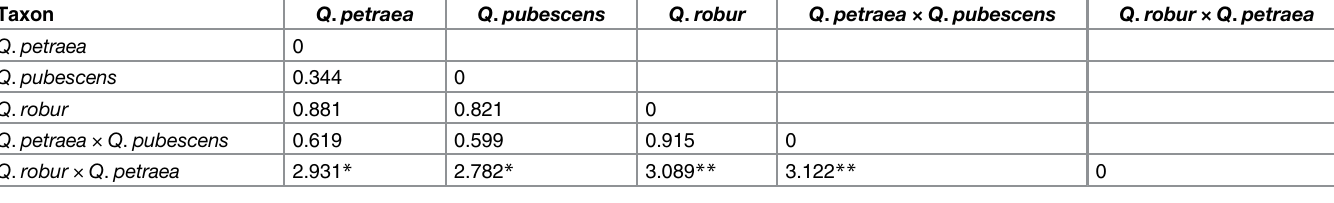
Table 5. Phenotypic distance between the taxa calculated on the basis P, E, P/E, Exp, Exp/P, Le, Le/P by Mahalanobis distance. Taxon